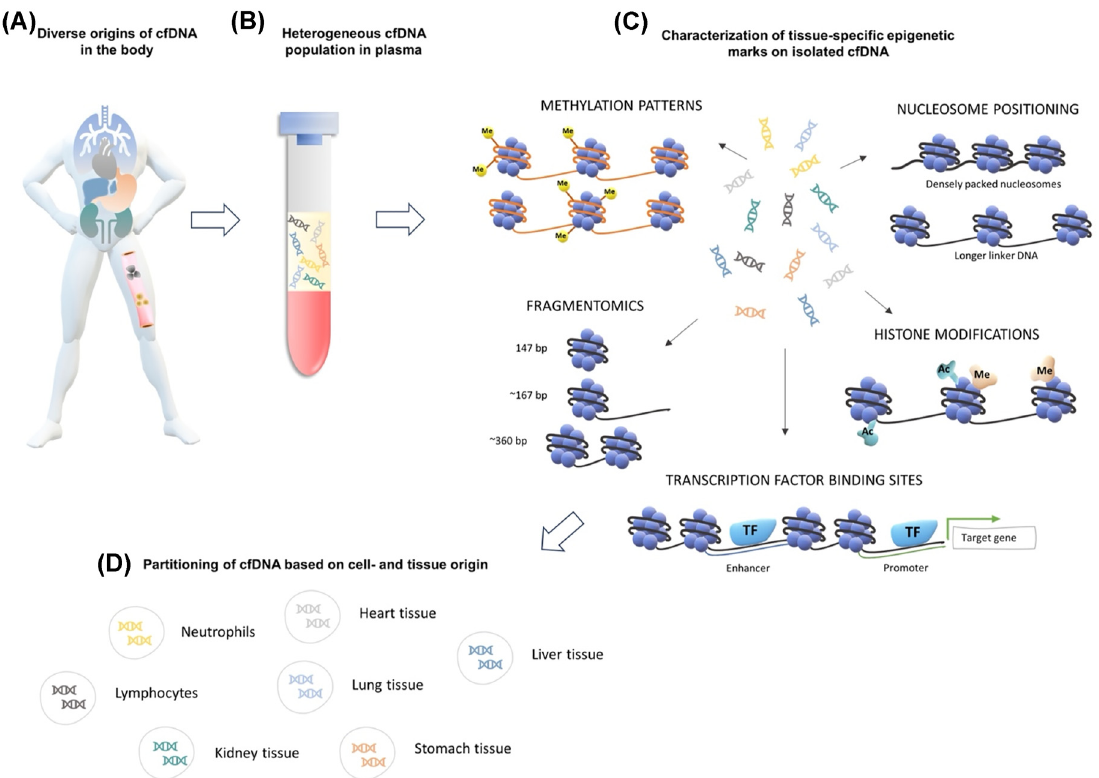
Figure 1: Determining the tissue-of-origin of cell-free DNA. (A) Cell-free DNA (cfDNA) can be released into blood plasma from various cell types and different organs. (B) This results in a